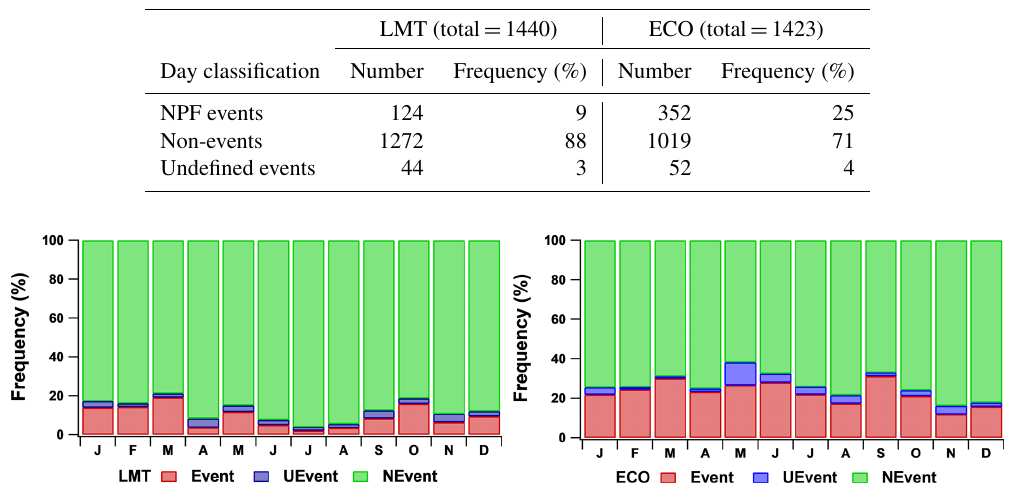
Table 1. Number of available days ( N ) and relative frequencies ( f %) of each class, NPF event, non-event, and undefined event detected in ECO and LMT observatories.